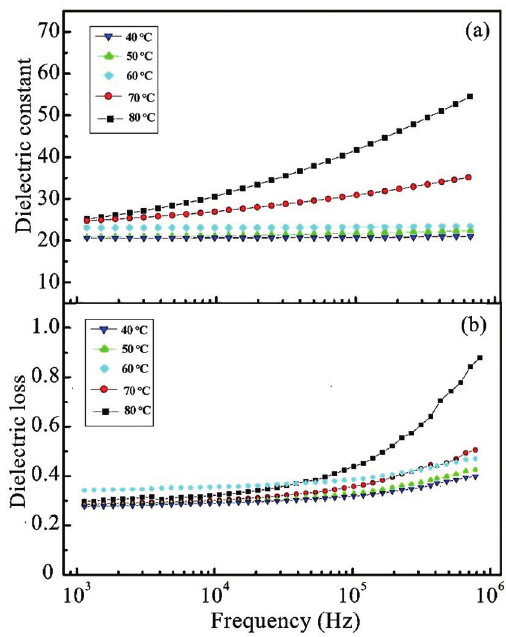
Figure 8: (a & b) Dependence of dielectric constant/dielectric loss on various frequencies and temperatures